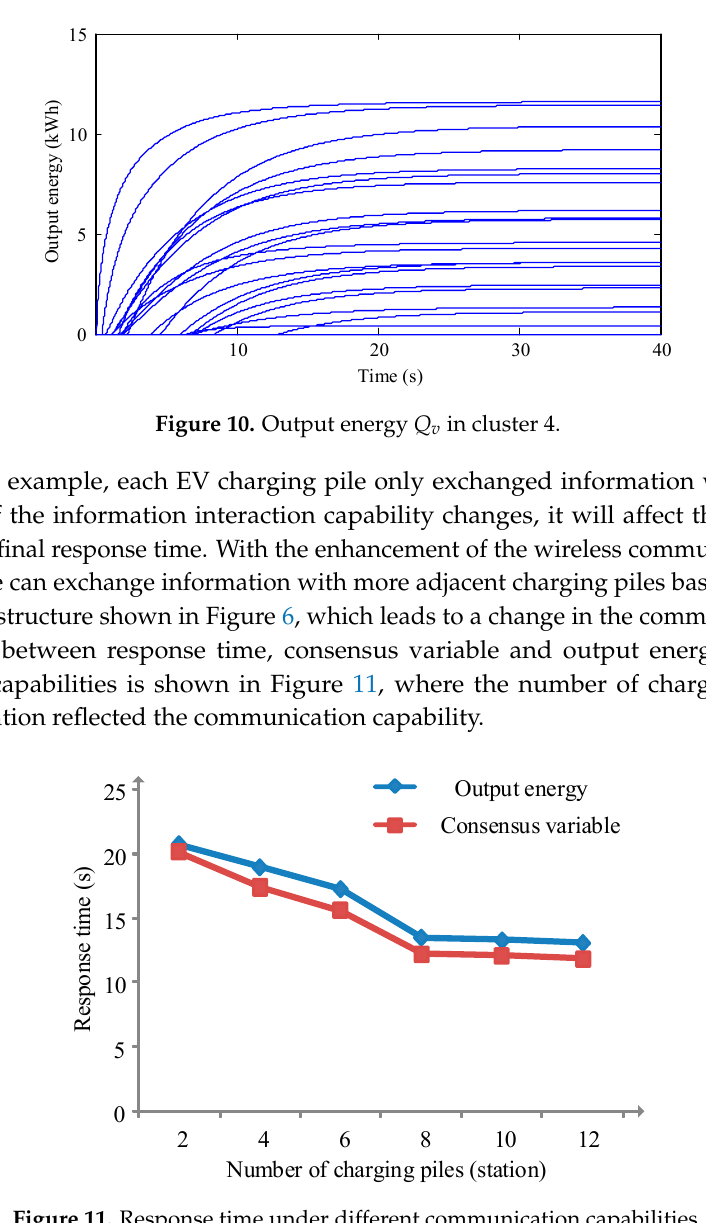
Figure 9. Consensus variables λ v in cluster 4.